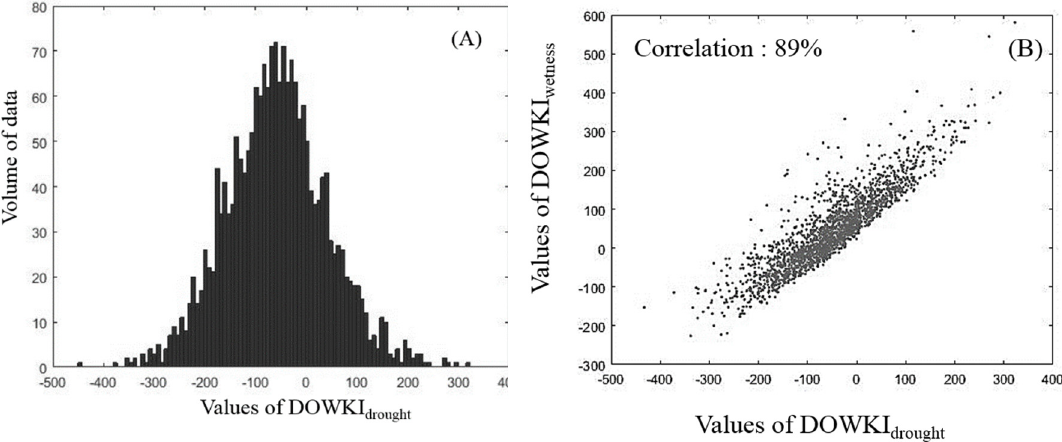
Figure 4. ( A ) Empirical distribution of the DOWKI drought values at the department scale calculated on the historical data. ( B ) Correlation between the indices DOWKI drought and DOWKI wetness : one data being one year / one department.